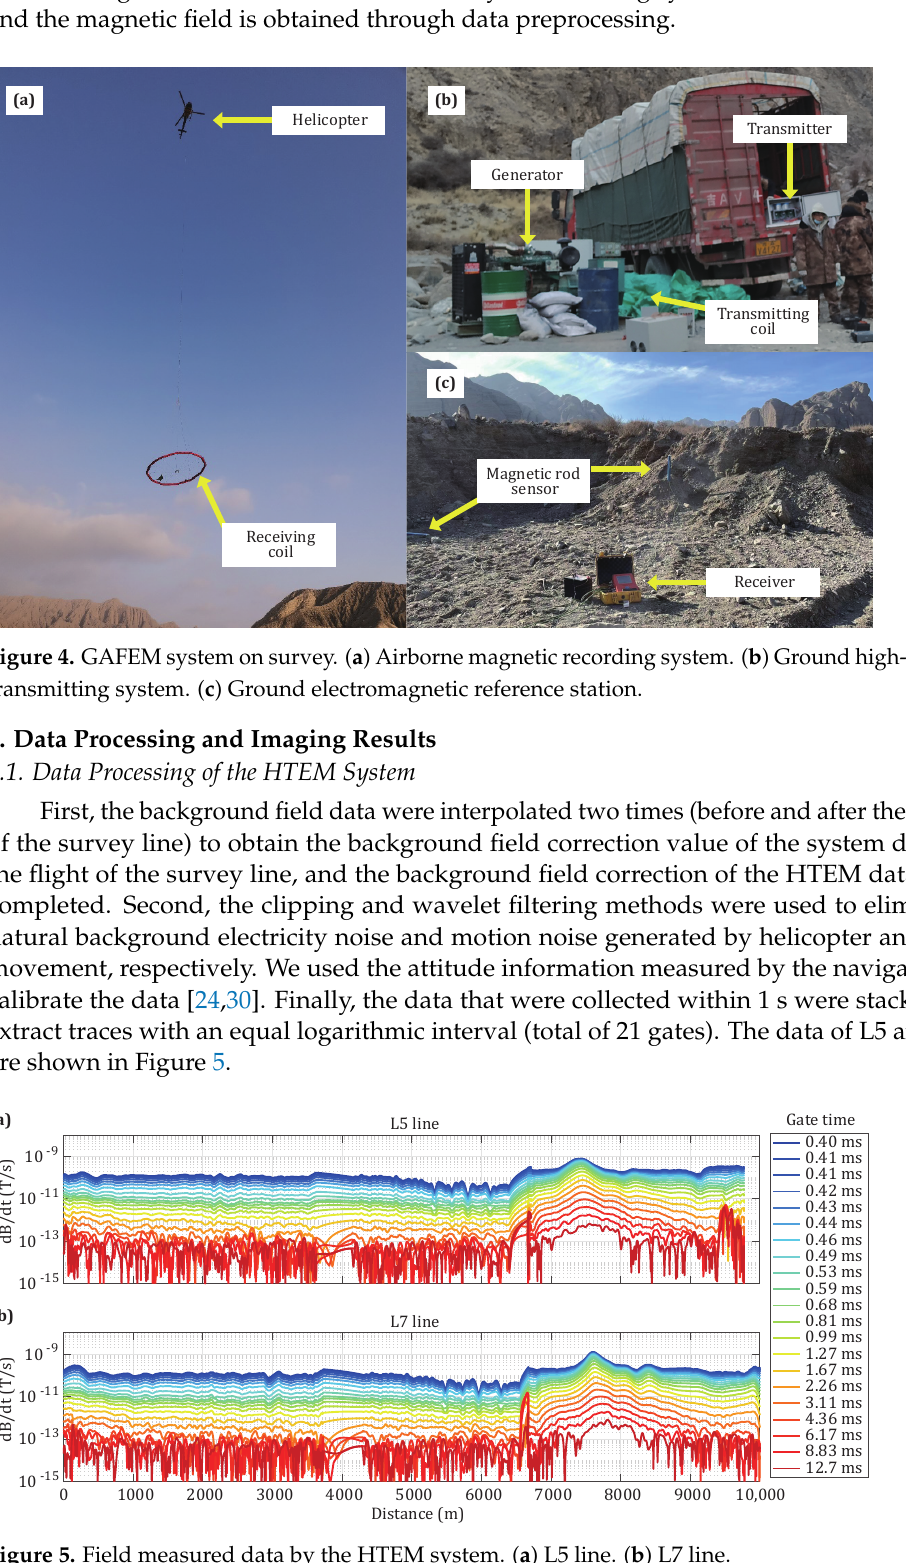
Figure 5. Field measured data by the HTEM system. ( a ) L5 line. ( b ) L7